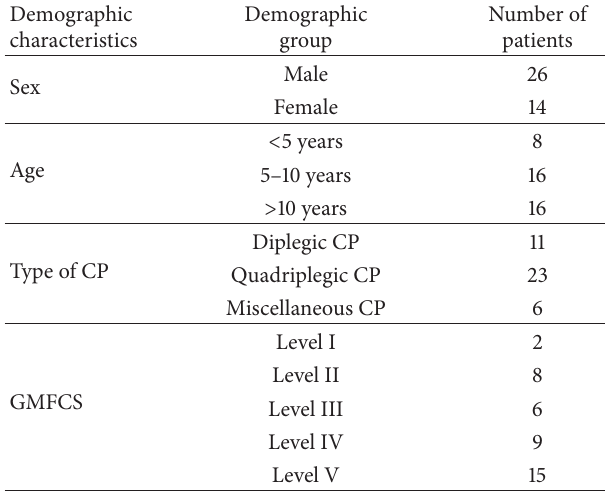
Table 1: Demographical data (total number of patients =